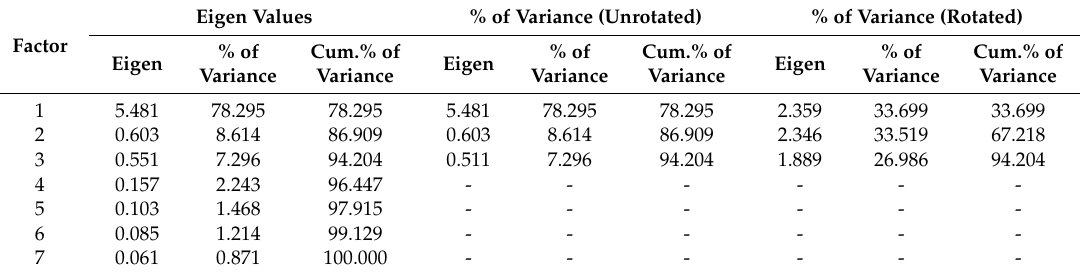
Table 2. Assessment results of variable